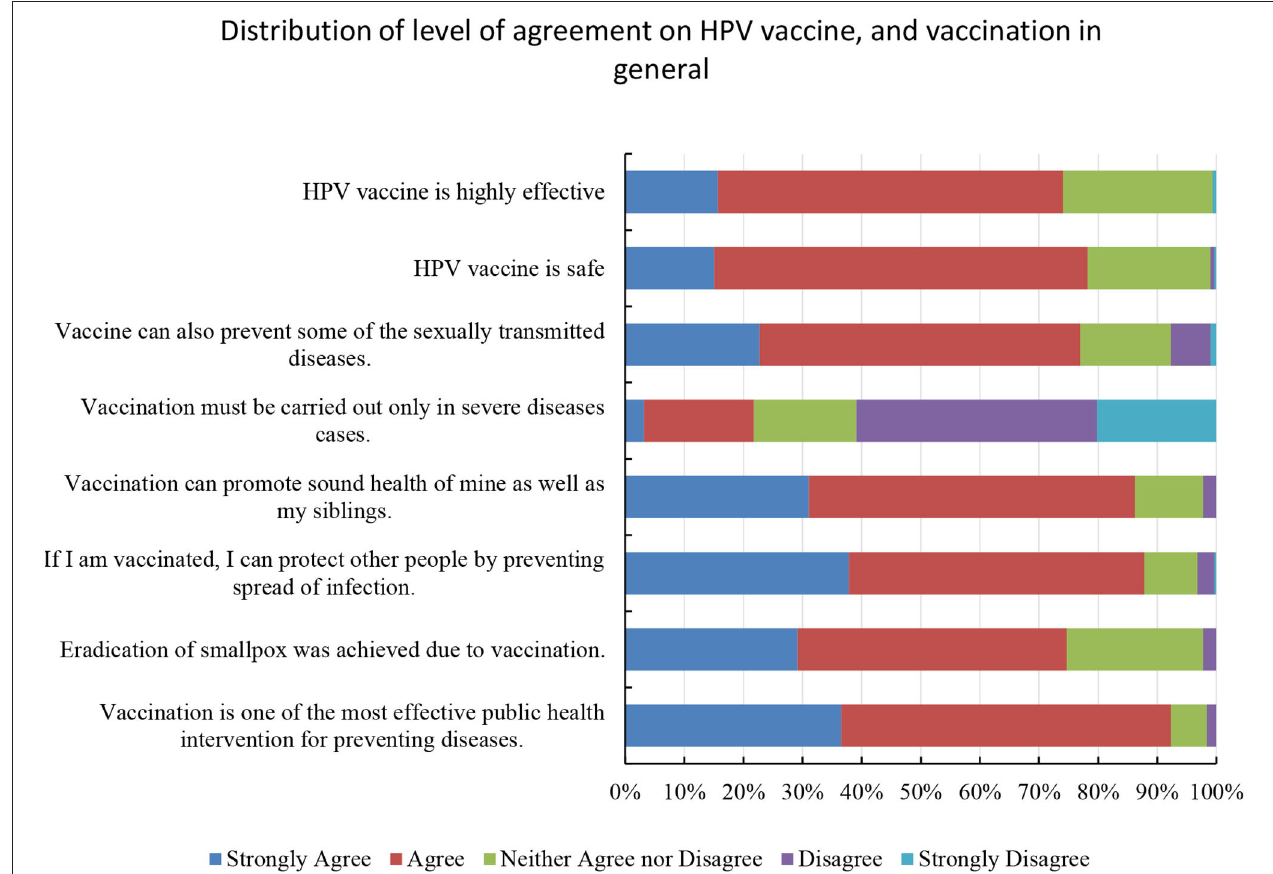
FIGURE 1 | Bar graph illustrating the level of agreement on HPV vaccine and vaccination in general. Participants showed a positive attitude toward the HPV vaccine’s safety and efficacy with more than 70% stating that the HPV vaccine is safe and effective. In addition, the participants were also positive toward the vaccine and vaccination in